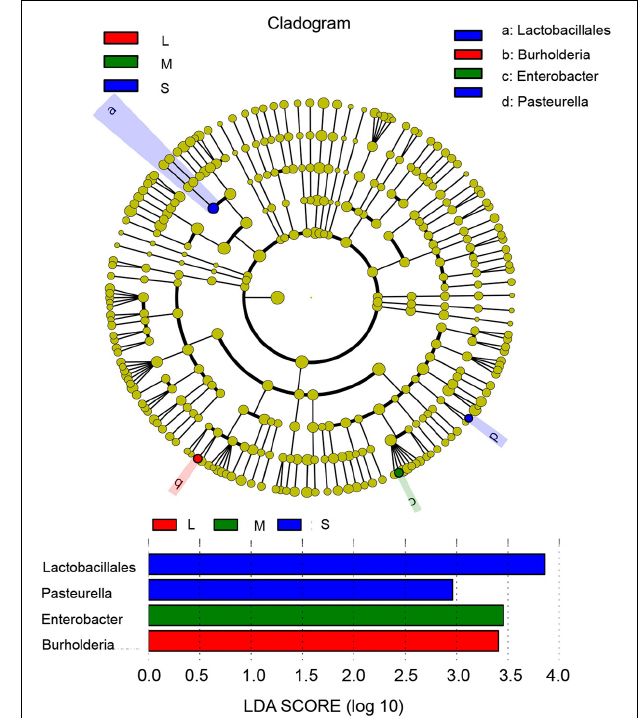
FIGURE 7 | Differentially abundant taxa identified among samples of three sizes by linear discriminant analysis coupled with effect size (LEfSe) (LDA score > 2.0, P < 0.05). S, M, and L represent sizes. Blue box: enriched in S samples, green box: enriched in M samples, and red box: enriched in L